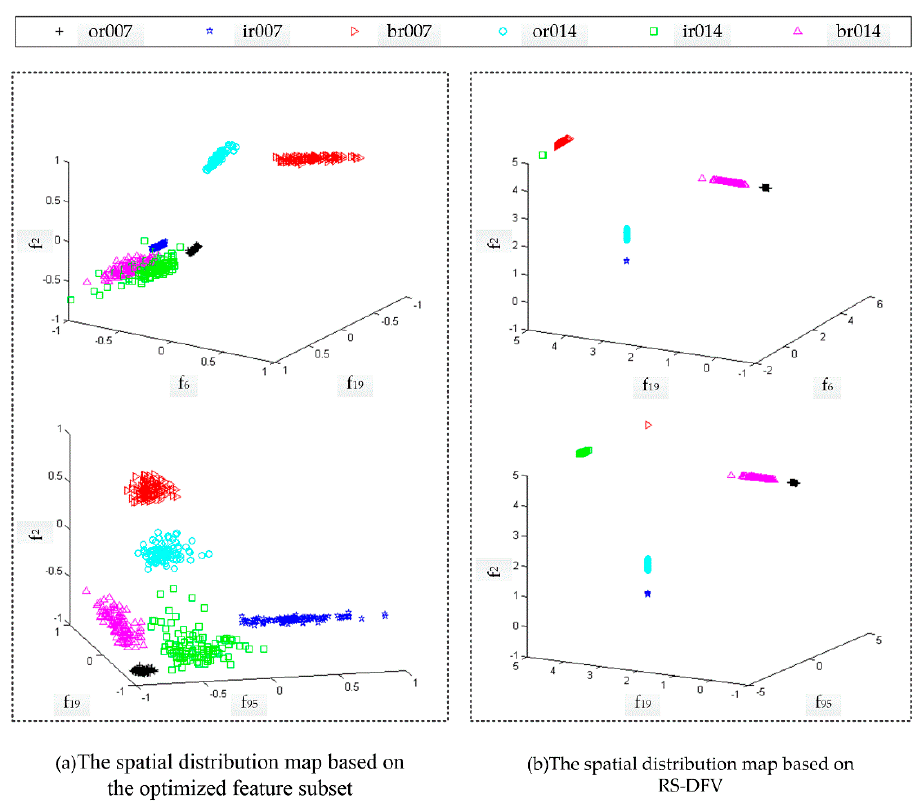
Figure 12 . The feature selection tree of the REB faults.